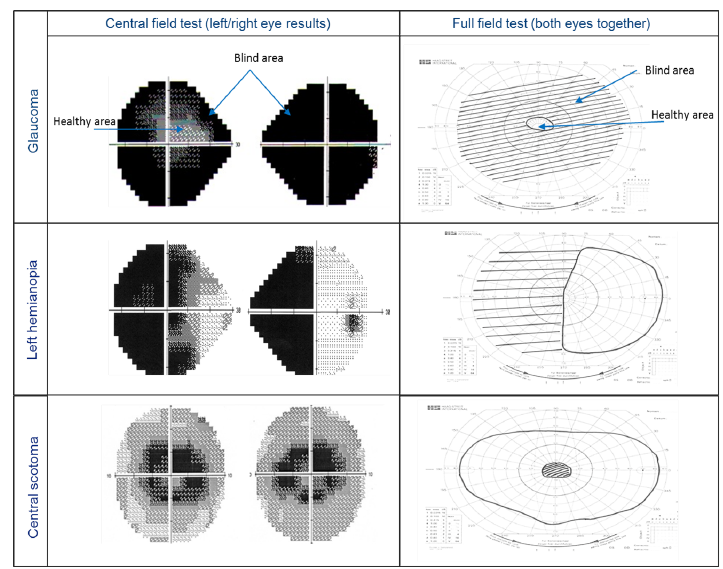
Figure 5. Visual field test result examples. The first row shows severe glaucoma (tunnel vision), the second row shows left hemianopia (blind to the left side, healthy in the right side) and the third row is an example of central scotoma (blind area).